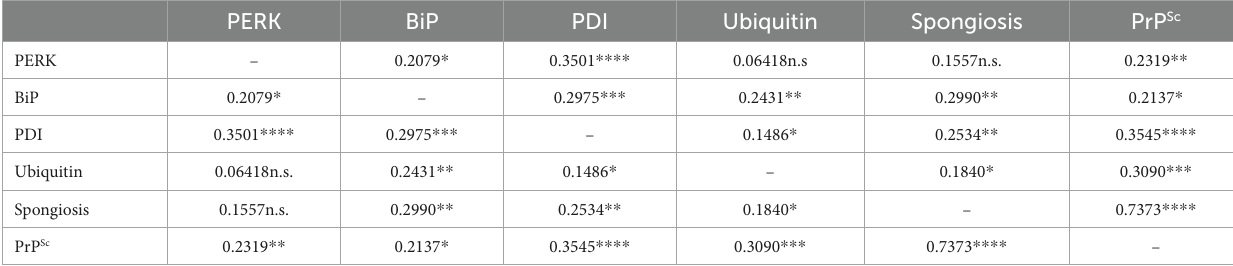
TABLE 3 Spearman’s correlation values between scores of endoplasmic reticulum (ER) stress, proteasome impairment markers, and prion-associated histopathological lesions. PERK BiP PDI Ubiquitin Spongiosis PrP